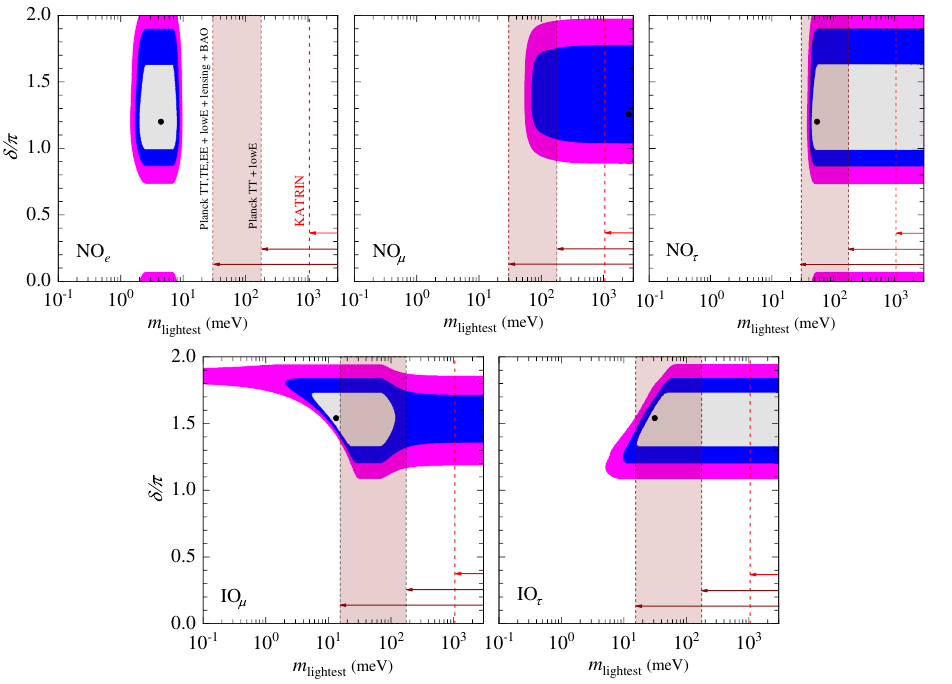
Figure 6 . Allowed regions in ( m lightest , δ ) for NO (upper plots) and IO (lower plots) for the Z 8 model. The colour code for the allowed regions is the same as in figure 5. The vertical shaded region corresponds to the upper-limit range for m P m k (see text). The vertical dashed red line shows the m lightest upper limit from the m β < 1 . 1 eV k KATRIN limit (90%